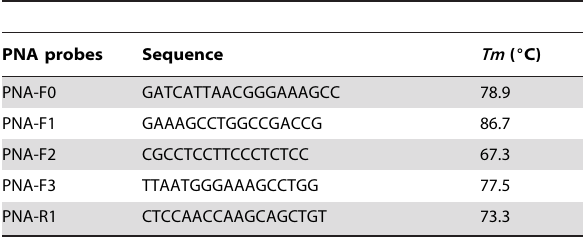
Table 2. Sequences and melting temperature ( Tm ) of PNA probes used in this study.